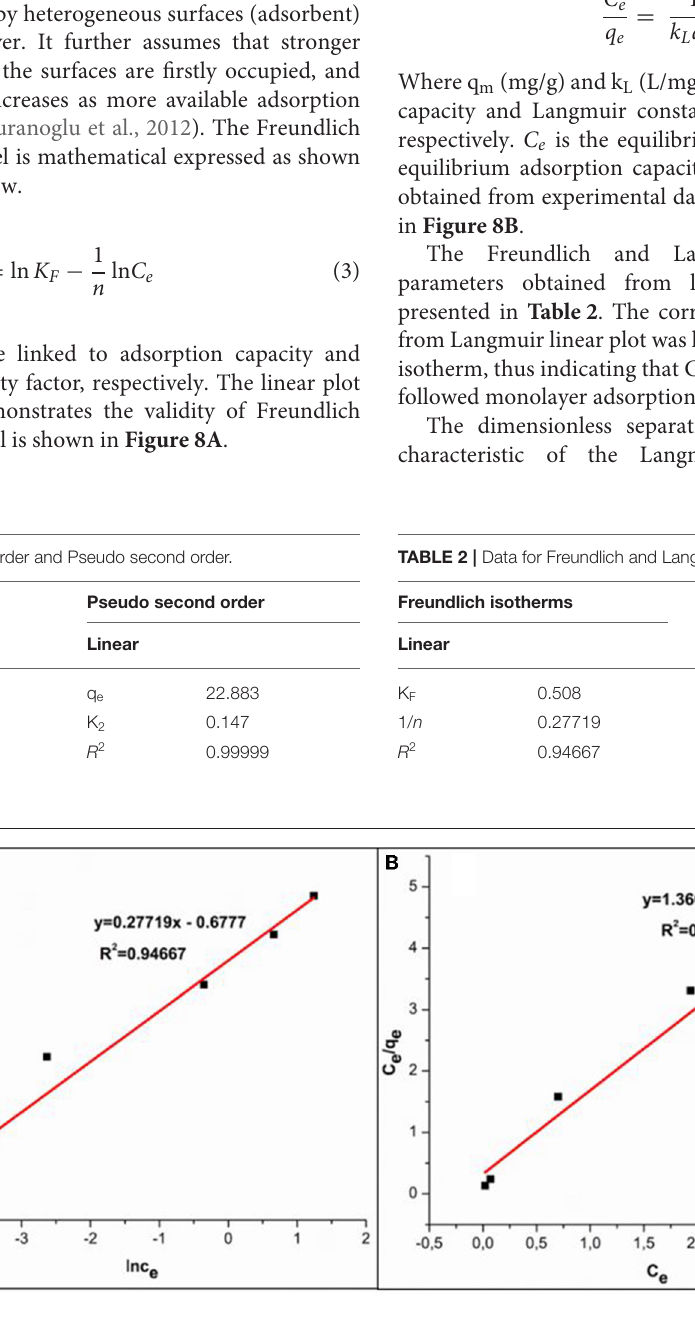
FIGURE 8 | (A ) Freundlich isotherm; (B) Langmuir isotherm for Cr(VI) adsorption by Fe 3 O 4 /FMO.